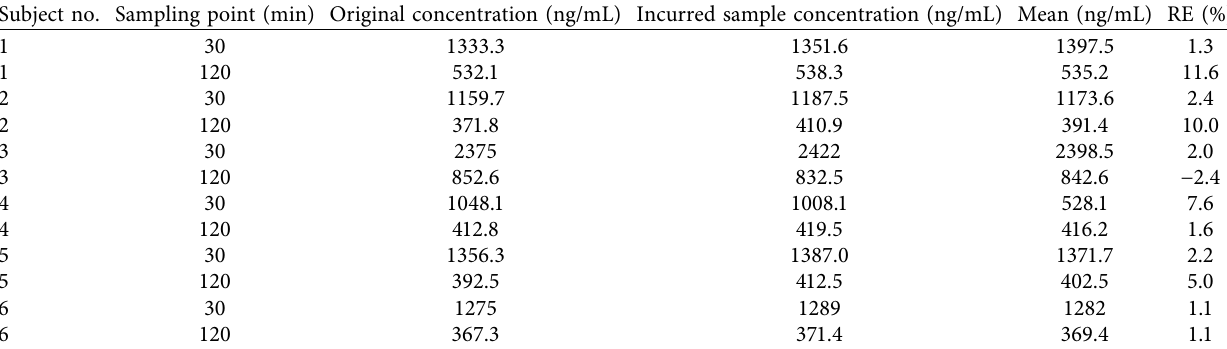
Table 3: Incurred sample reanalysis data of gastrodin.